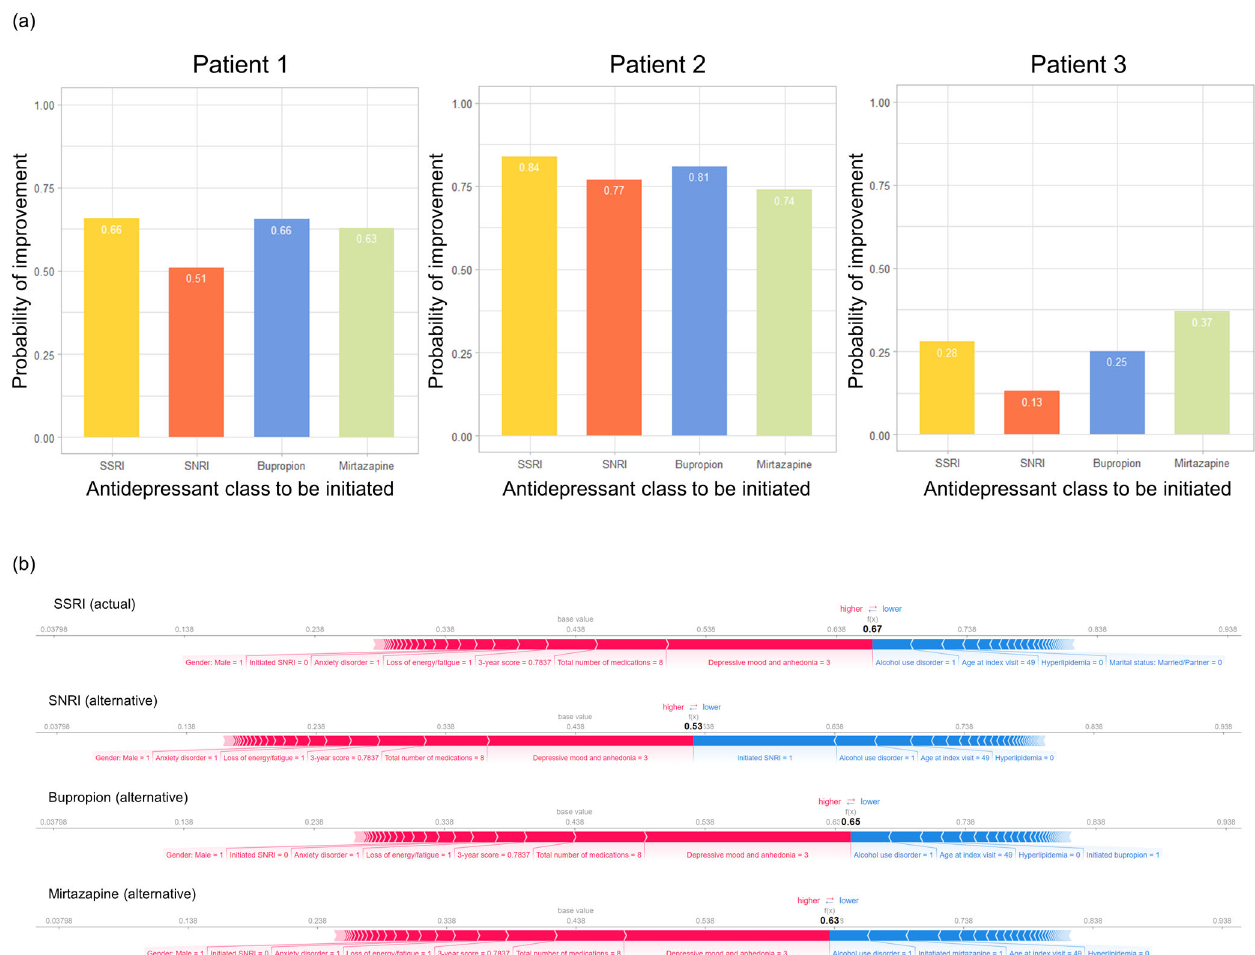
Fig. 3 Illustration of differential treatment response predictions and local predictor importance for different treatment scenarios. a Predicted response for actual and alternative treatments for three patients randomly drawn from strata that were modeled to be moderately likely (Patient 1), highly likely (Patient 2), and less likely (Patient 3) to respond, respectively, to the actual antidepressant class prescribed. Results are shown for the representative model (feed-forward DNN). b “ Force plots ” 47 illustrating local predictor importance (by SHAP score) for each of the treatment scenarios for Patient 1 from a . The patient was a 49-year-old male with co-morbid alcohol used disorder, depressed mood/anhedonia, anxiety symptoms, fatigue/loss of energy, and 8 co-occurring medications prescribed in the past 3 months, who was started on an SSRI. The directions and strengths of each predictor are shown in directed bars in either blue or red. Only predictors with strengths greater than a threshold level are captioned. The bars denote predictors that decrease (blue) or increase (red) the likelihood of response from base value (i.e., sample mean response probability). Longer bars indicate stronger contributions to predicted